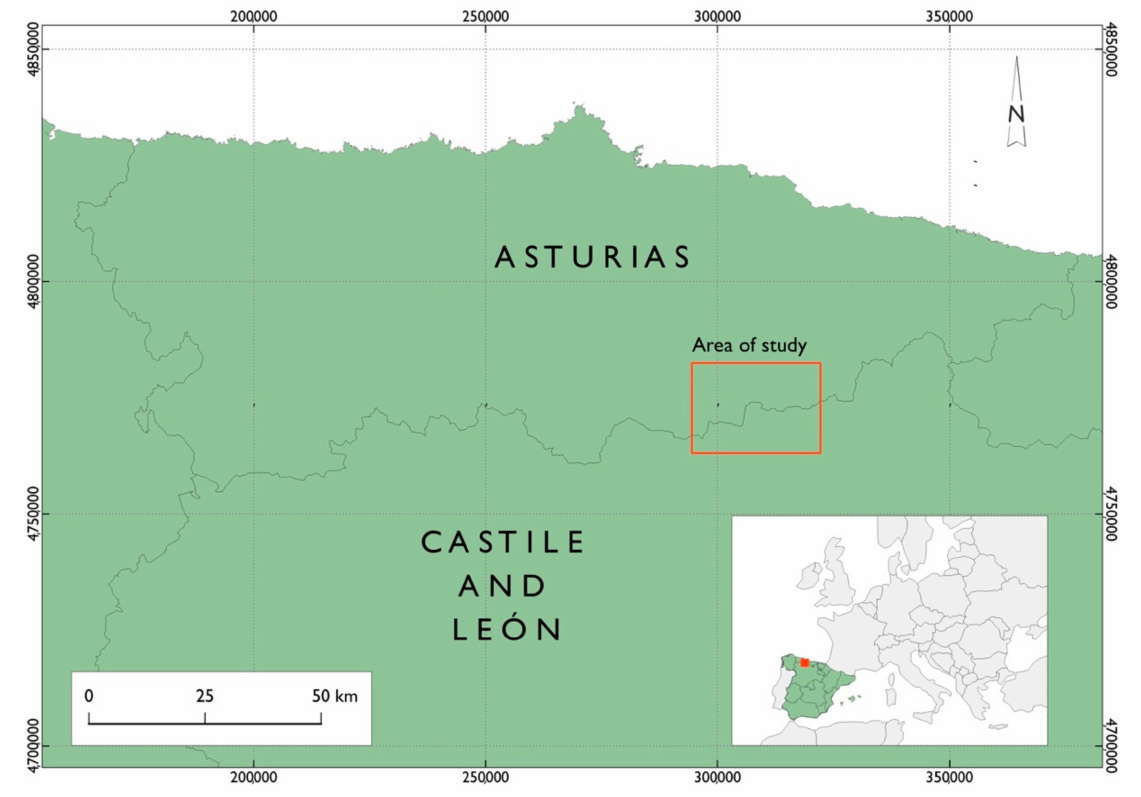
Figure 1. Map with the location of the area in the central-eastern area of the Asturian Massif (Spain). Composed by the